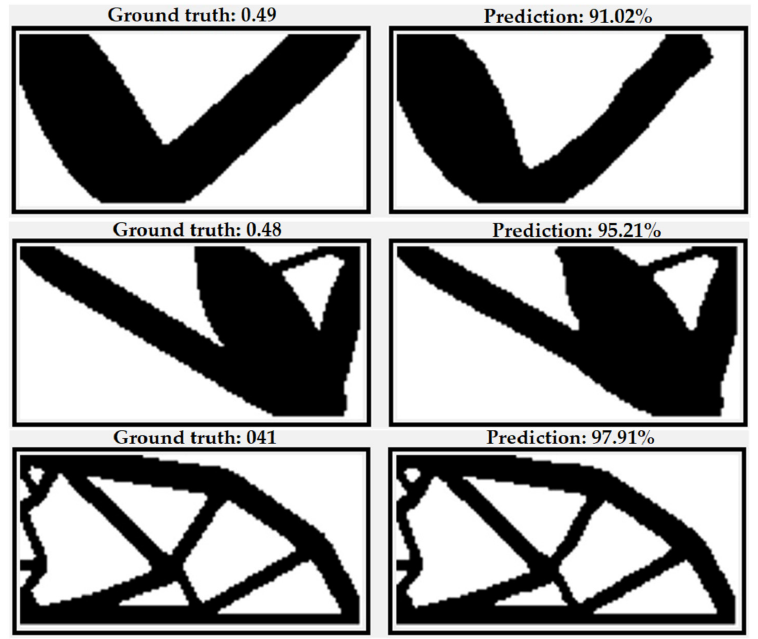
Figure 9. Outputs of SIMP ( left ) and Res-U-Net ( right ) from Dataset #2. In the images of ground truth, 0.49, 048 and 0.41 describes volume fractions.